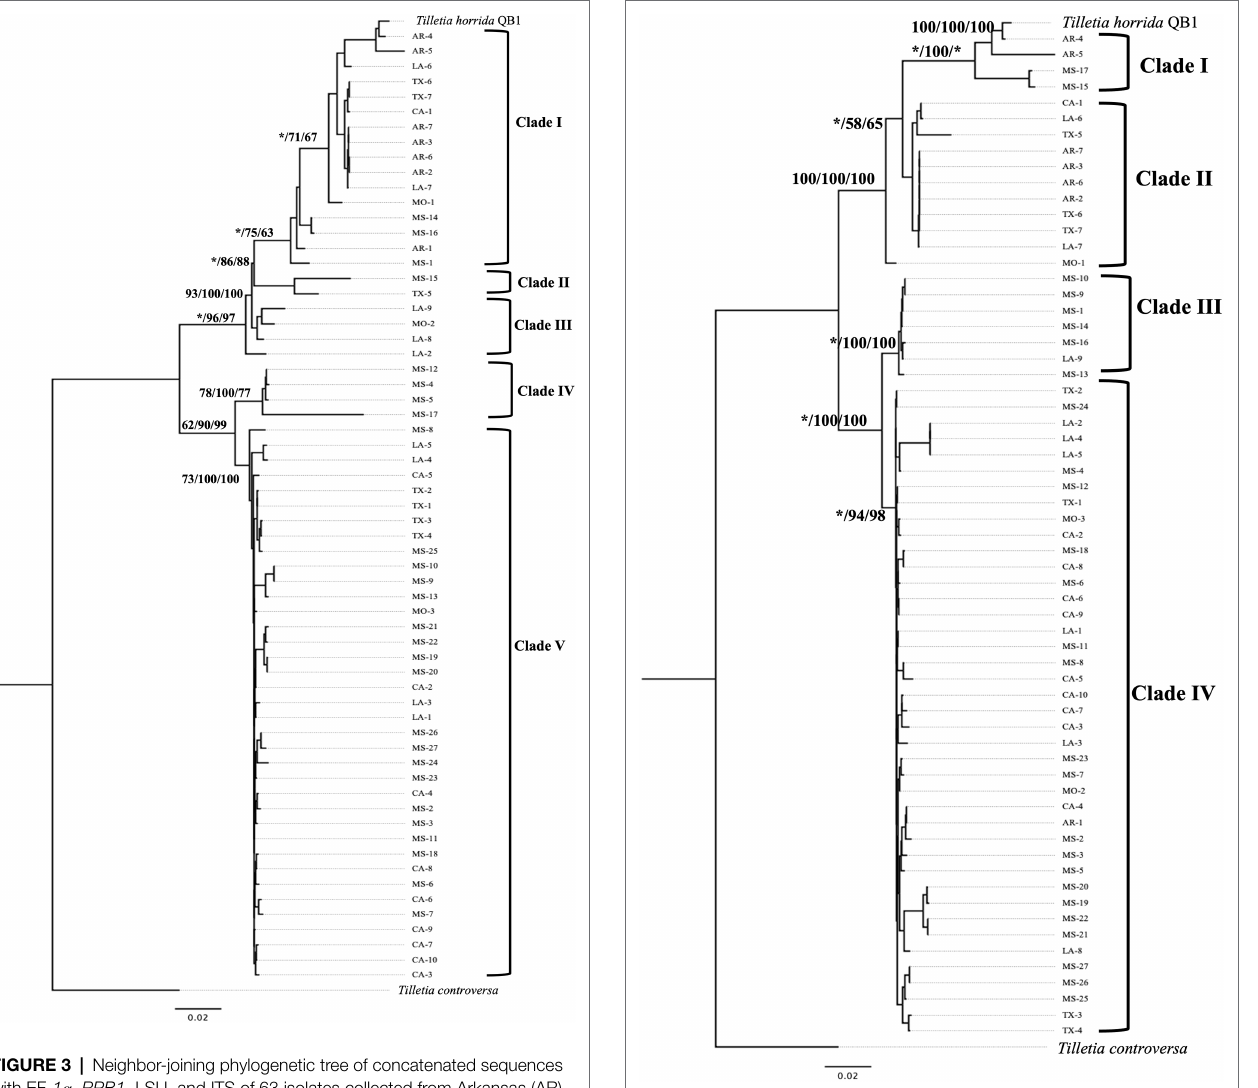
FIGURE 4 | Neighbor-joining phylogenetic tree of concatenated sequences with rRNA regions LSU, and ITS of 63 isolates collected from Arkansas (AR), California (CA), Louisiana (LA), Mississippi (MS), Missouri (MO), and Texas (TX) in the US. T. horrida strain QB1 was used as a reference isolate and T. controversa strain DAOMC 236426 was used as an outgroup. The scale bar represents the number of substitutions per site. The value on the branches indicates the percentage of trees based on 1,000 bootstrap replicates on ML/NJ/ME, respectively. Only branches values with >50% replicates are shown; “*” indicates that the branch value is less than